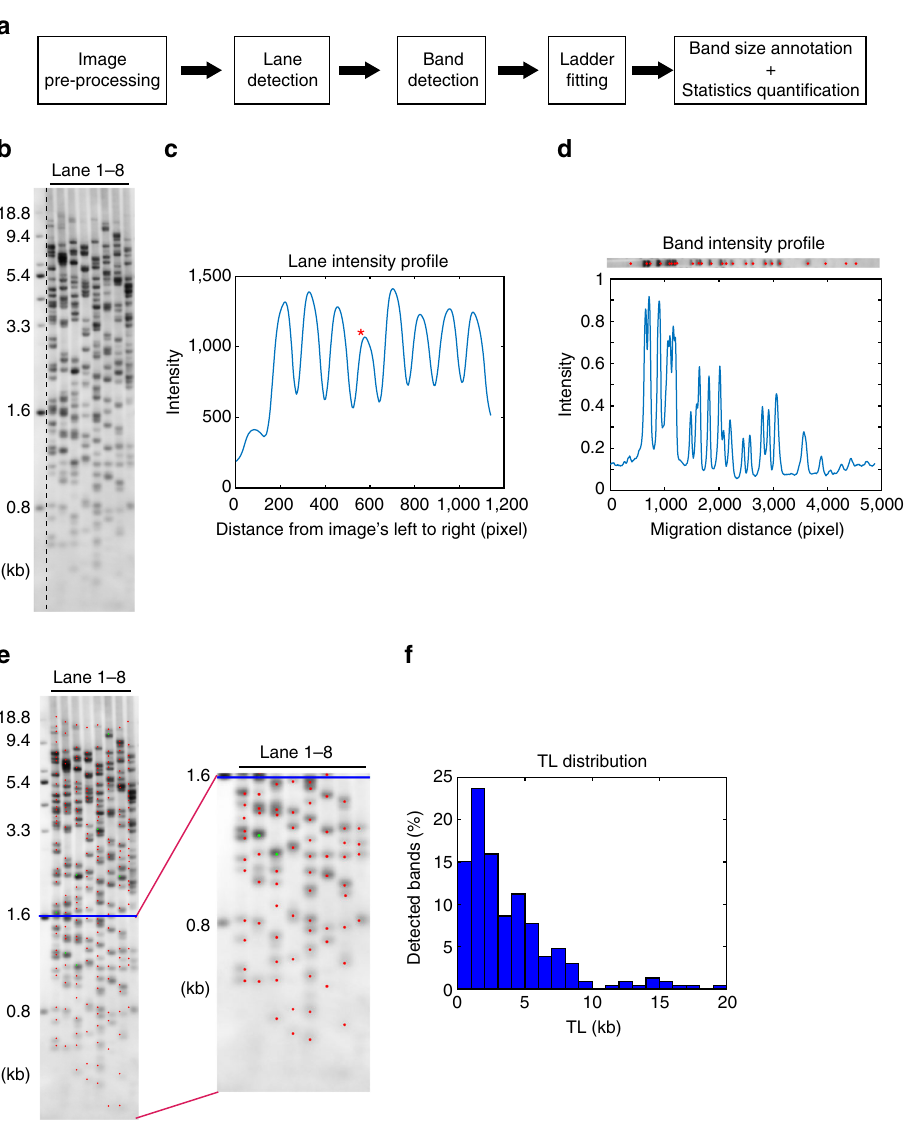
Fig. 3 Overview of TeSLA image quanti fi cation software. a The computational analysis pipeline automatically detects each telomere band location, then annotates the band sizes, and calculates the relevant statistics (e.g., average TL, the ratio of shortest TL, TL at 20th percentile, and telomeres below 1.6 kb). b Example of input TeSLA image, tiff format recommended. On the left side of the image is the ladder lane with a standard size of 0.8 – 18.8 kb. c Lane pro fi le, generated by summarizing the pixel intensity values vertically from left to right. Each peak indicates one lane detected by the software. d Band pro fi le of lane 4, marked with the asterisk in c . The band pro fi le is generated for each lane by horizontally summarizing pixel intensity values. Each signi fi cant peak refers to an individual band. e Example of the fi nal output with the zoom-in of shortest telomere bands. Red dots indicate individual bands. Green dots mark the overlapping bands that are counted twice or three times. The blue line crosses the marker of 1.6 kb, which is the default threshold of shortest TL that other methods cannot reach. The software can calculate the ratio of TL below any given threshold. f Histogram of TL distribution, which covers the range of 0 – 20